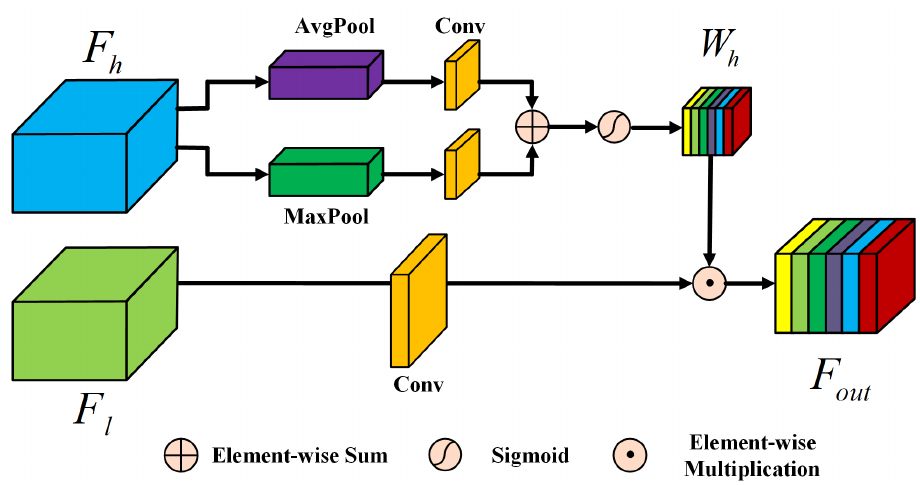
Figure 7. Architecture of the attention unit